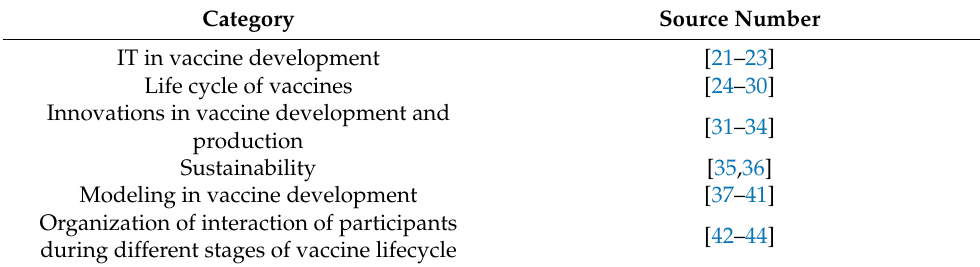
Table 1. MatriX of articles collected initially with SCOPUS.